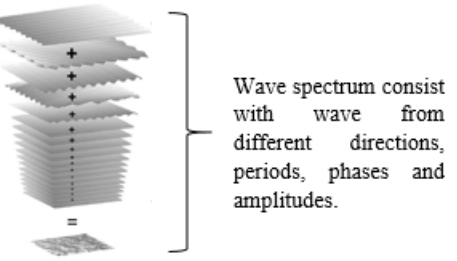
Figure 2. The generation of wave spectrum (Holthuijsen, 2007). Three components of wave that defined the wave dimensions are height, length and period. Wave height is defined as the vertical distance measured from the trough to the crest of the wave while, wave length is a distance measured between crests or (troughs) as shown in Figure 3. Wave period is the time elapsed between the passing of successive crests or (troughs).